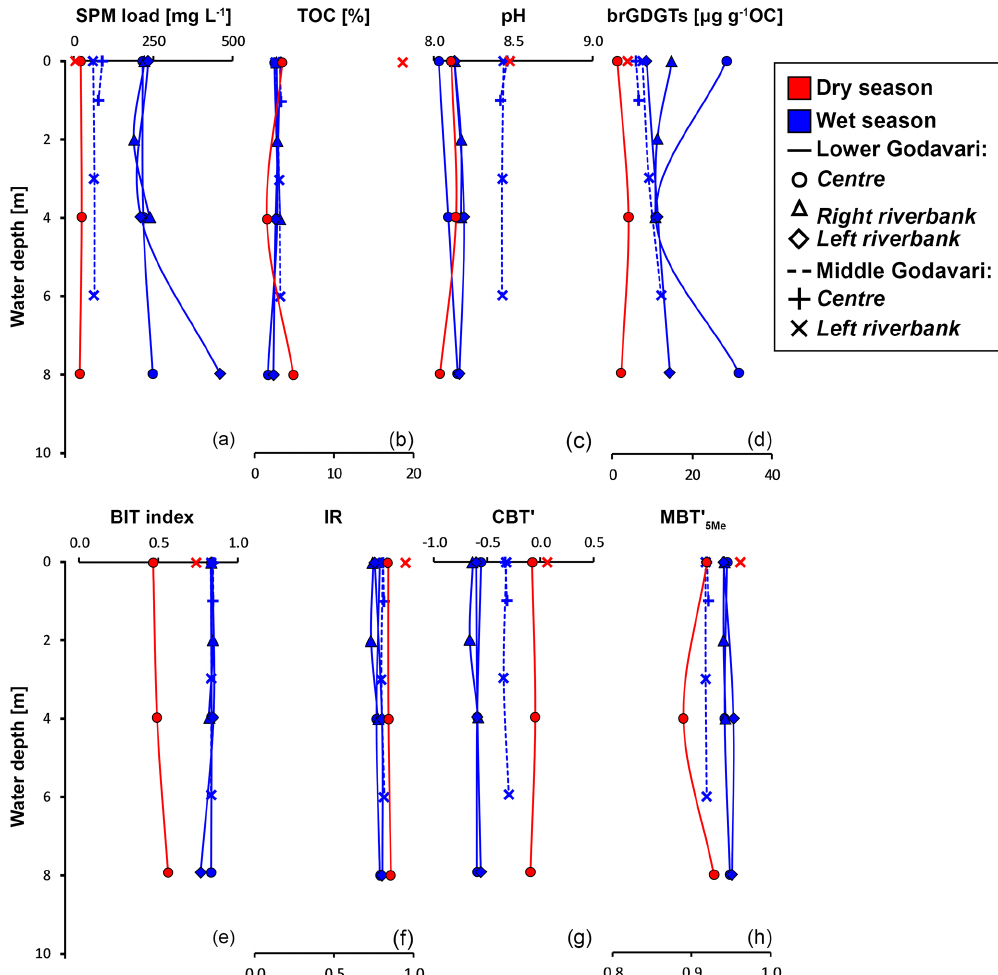
Figure 3. River depth profiles of bulk properties: (a) suspended particulate matter (SPM) load, (b) total organic carbon (TOC), (c) measured pH in the water column, and (d) brGDGT concentration. River depth profiles of brGDGT-based indices: (e) BIT index, (f) isomer ratio (IR), (g) CBT (cid:48) , and (h) MBT (cid:48) index values. The symbols represent the position in the channel: mid-channel (centre) and near the left and right 5Me riverbank. In the lower Godavari, the right is the non-eroding riverbank and the left is the eroding